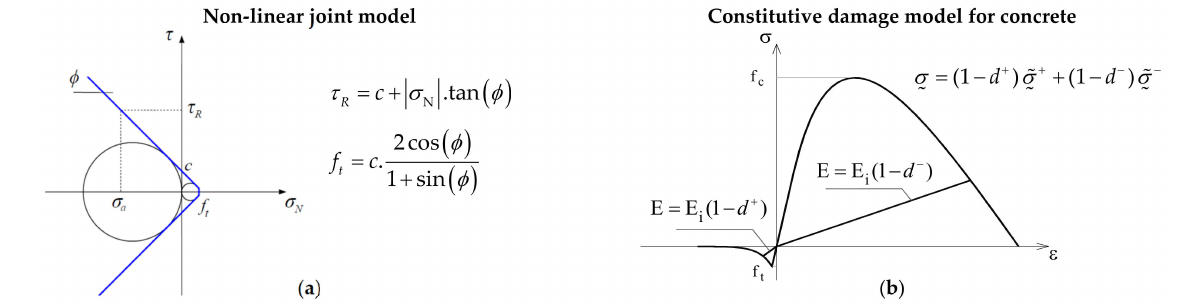
Figure 6. ( a ) Non-linear joint model with cohesion and ( b ) Concrete constitutive model with two independent damage variables.